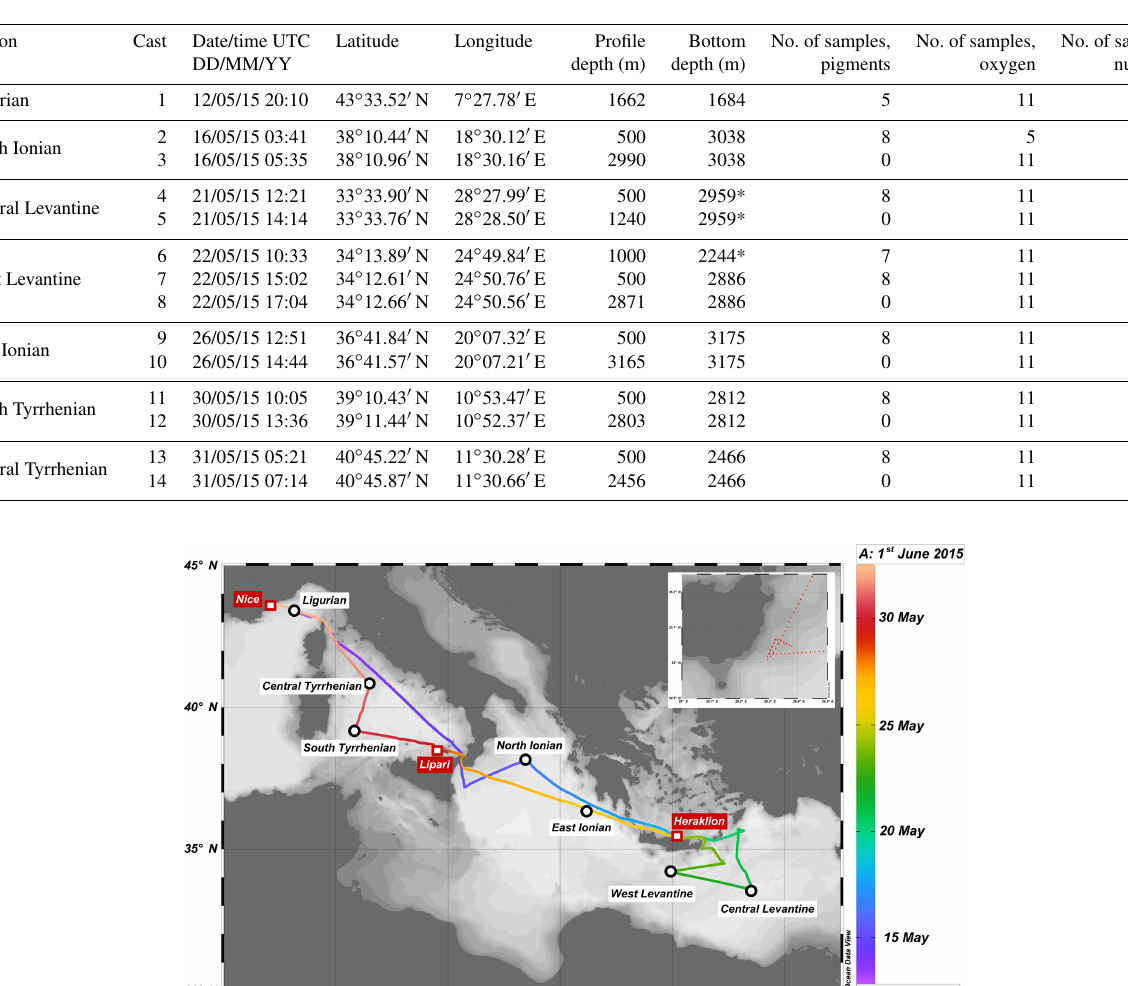
Table 1. Station summary. For bottom depth, values with asterisk indicate that the measurement was obtained from the vessel’s echo-sounder rather than the altimeter interfaced to the CTD unit.